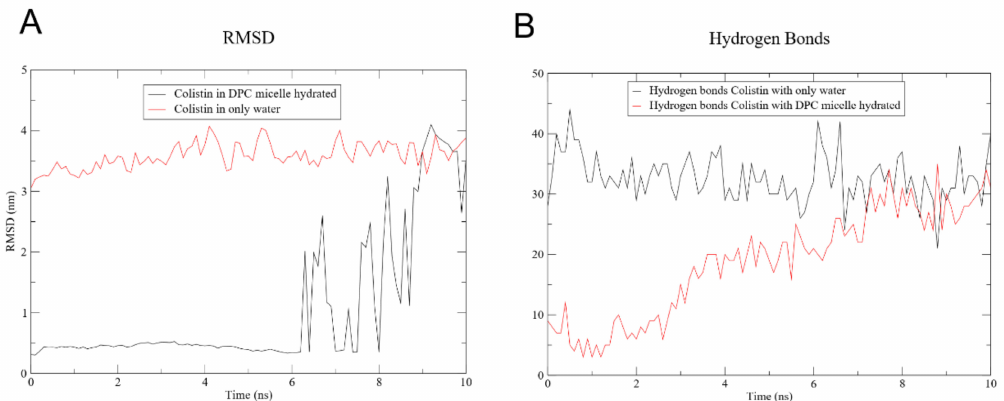
Figure 4. CST molecular dynamics (MD) analysis. ( A ) Root mean square deviation (RMSD) of the DPC micelle with CST and CST in water only. ( B ) Hydrogen bonds of DPC micelle with CST and CST in water only.